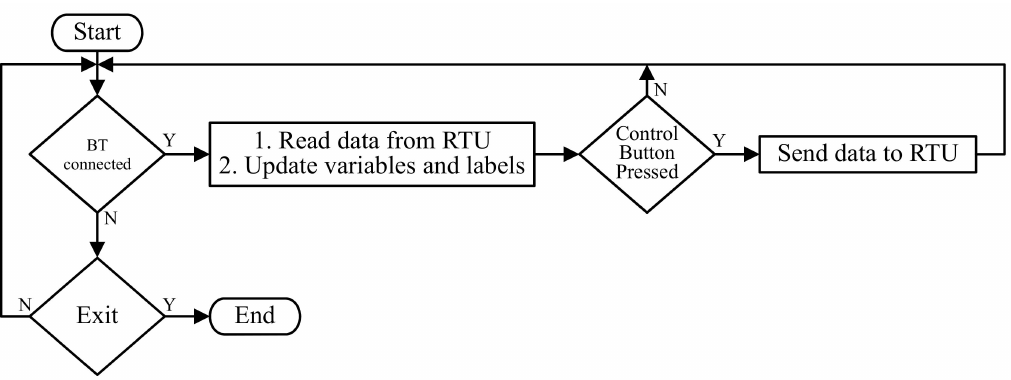
Figure 4. Algorithm of the Mobile App.